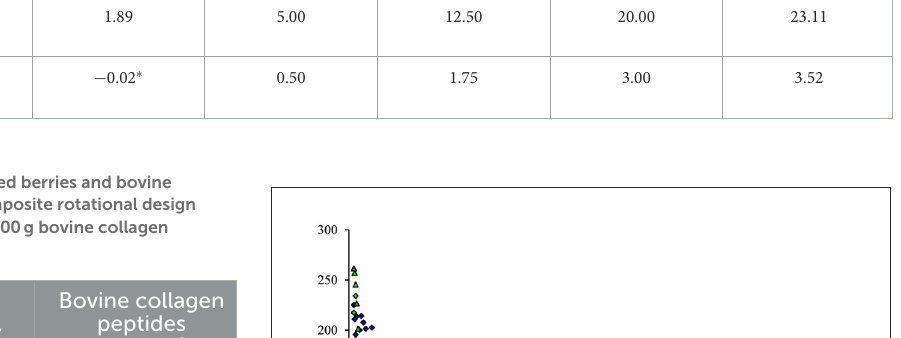
TABLE 1 The trial design and factor levels in encoded values applied in the central composite rotational design (CCRD) ( ∗ is a theoretically calculated value, 0/100g bovine collagen peptides were added). Variable